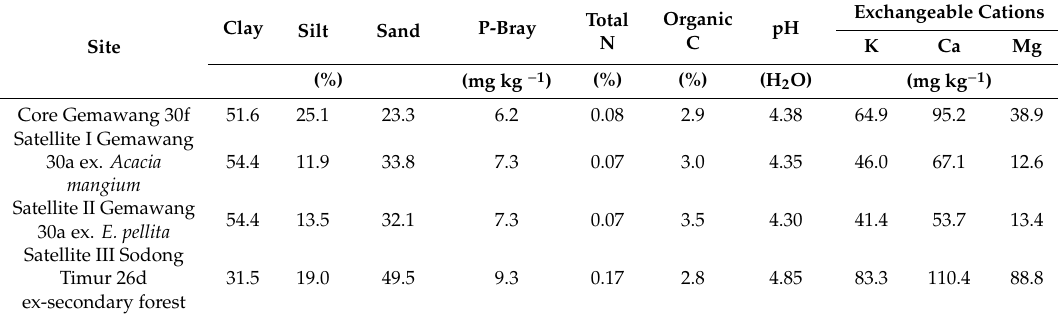
Table 1. Soil properties at 0–20 cm depth at the Core and Satellite I, II and III experiments.